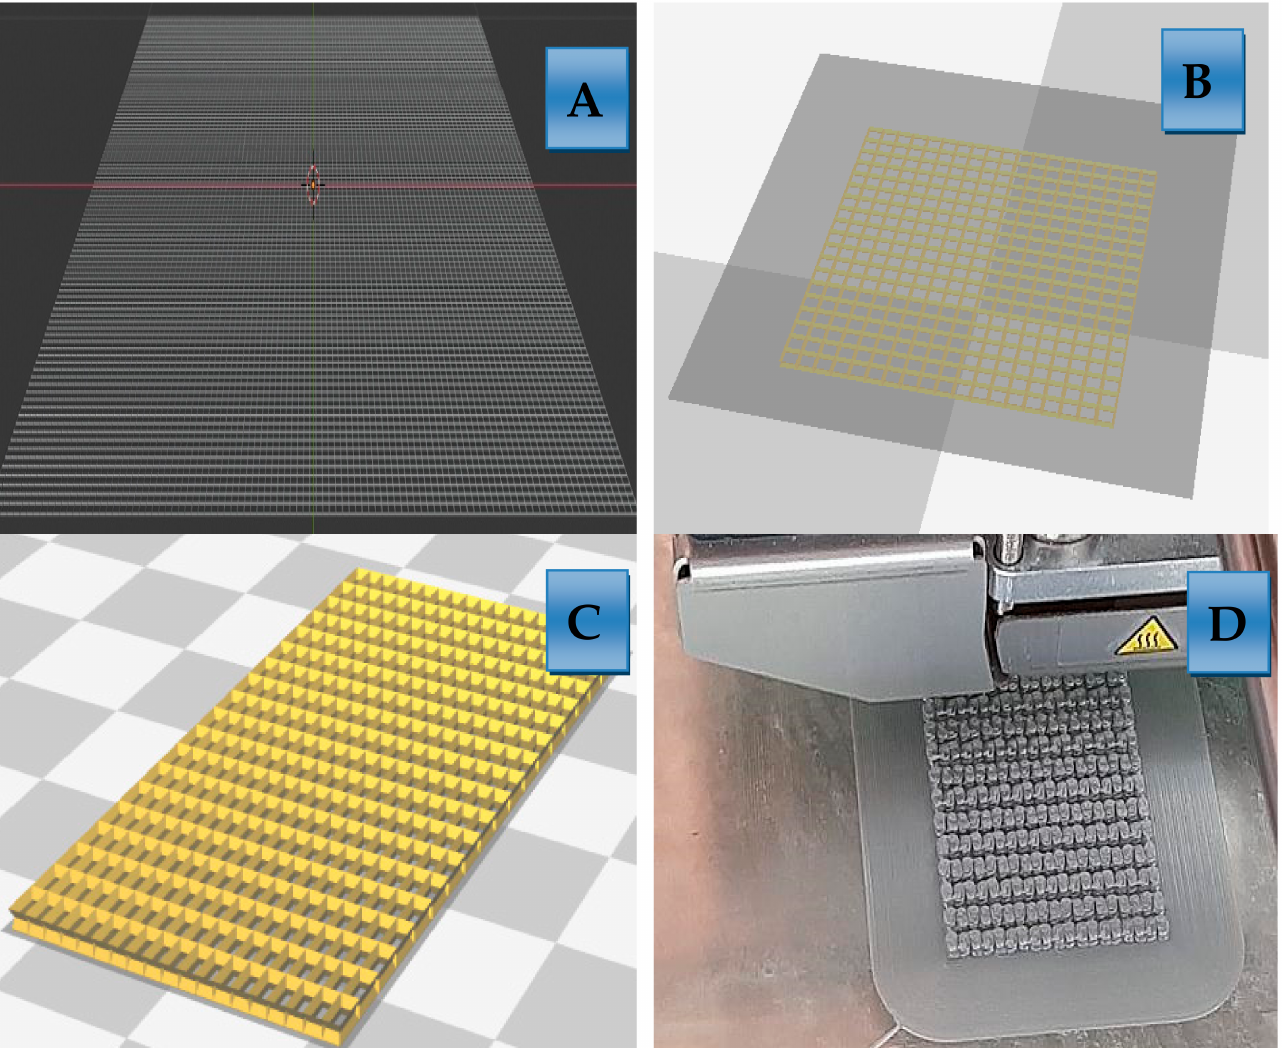
Figure 3. ( A ) Programming in Blender; ( B) Model generating in the Cura; ( C ) converting model to slices and ( D ) 3D